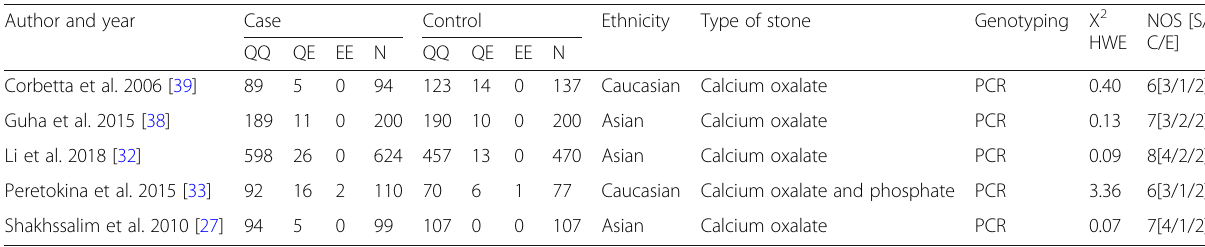
Table 3 Baseline characteristics of studies concerning CaSR Q1011E gene polymorphism in patients with urolithiasis included in the